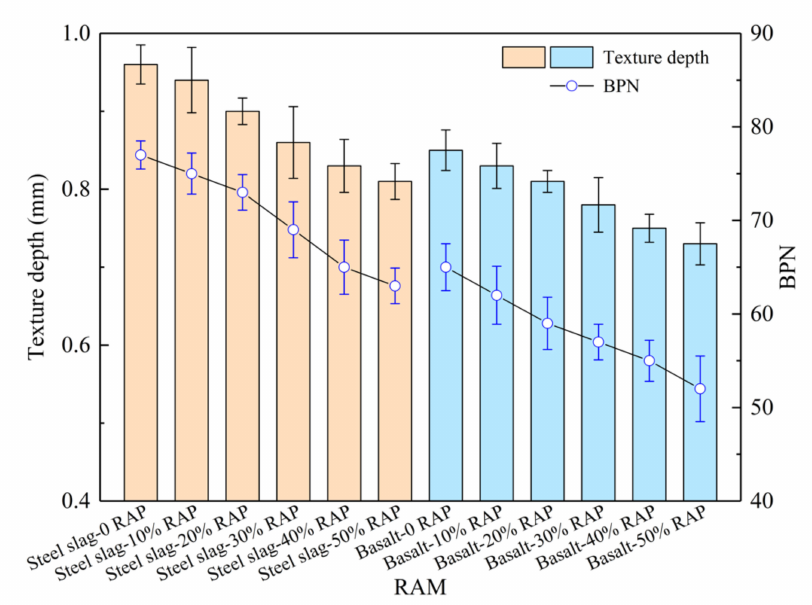
Figure 8. Texture depth and British Pendulum Number (BPN) results of